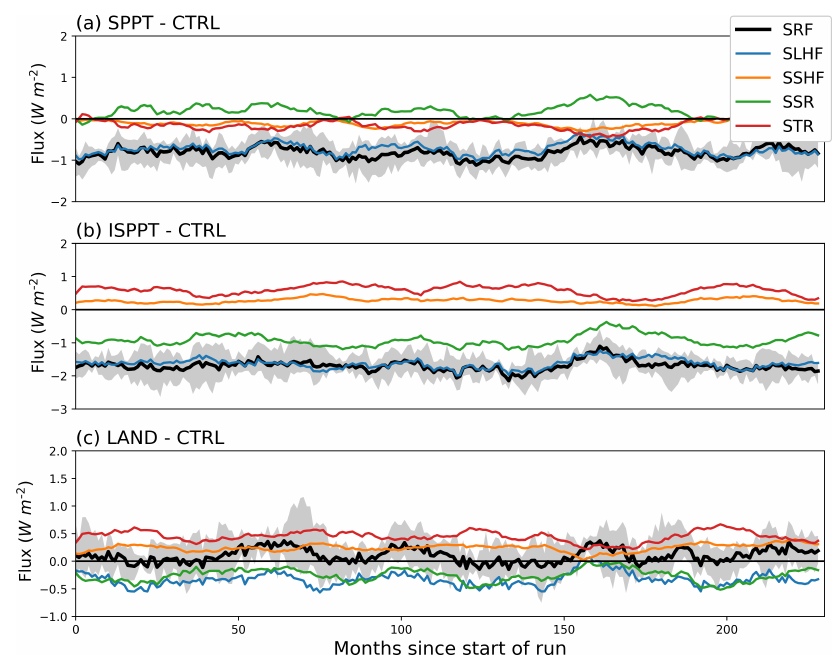
Figure 6. Global mean time series of energy fluxes for (a) SPPT minus CTRL, (b) ISPPT minus CTRL, and (c) LAND minus CTRL. Fluxes shown are latent heat flux (SLHF, blue), sensible heat flux (SSHF, orange), surface thermal radiation (STR, red), surface solar radiation (SSR, green), and net surface energy (SRF, black). Note the IFS convention that downward fluxes are positive and upward fluxes (such as sensible and latent heat flux) are negative. SRF is the sum of the other fluxes. The black shading captures 2 standard deviations around the SRF mean as sampled from the five individual differences. Time series have been smoothed with a 12-month running mean to remove the seasonal